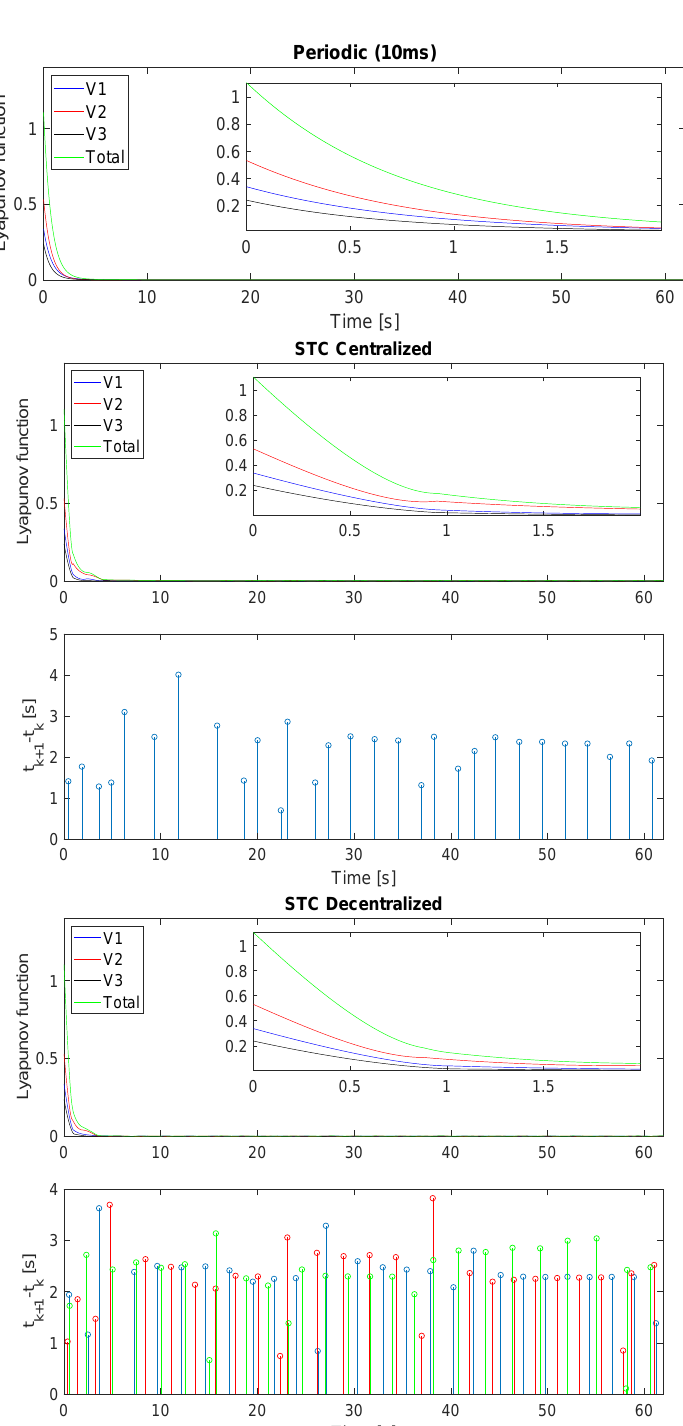
Figure 6. Lyapunov function of the formation including a zoom of the first 2 s and inter-execution times for STC startegies. Robot 1 is drawn in blue, Robot 2 in red, Robot 3 in black and the Formation in green. Top figure represents the periodic implementation, the middle one the STC with centralized triggering (26) and the bottom the STC with decentralized triggering